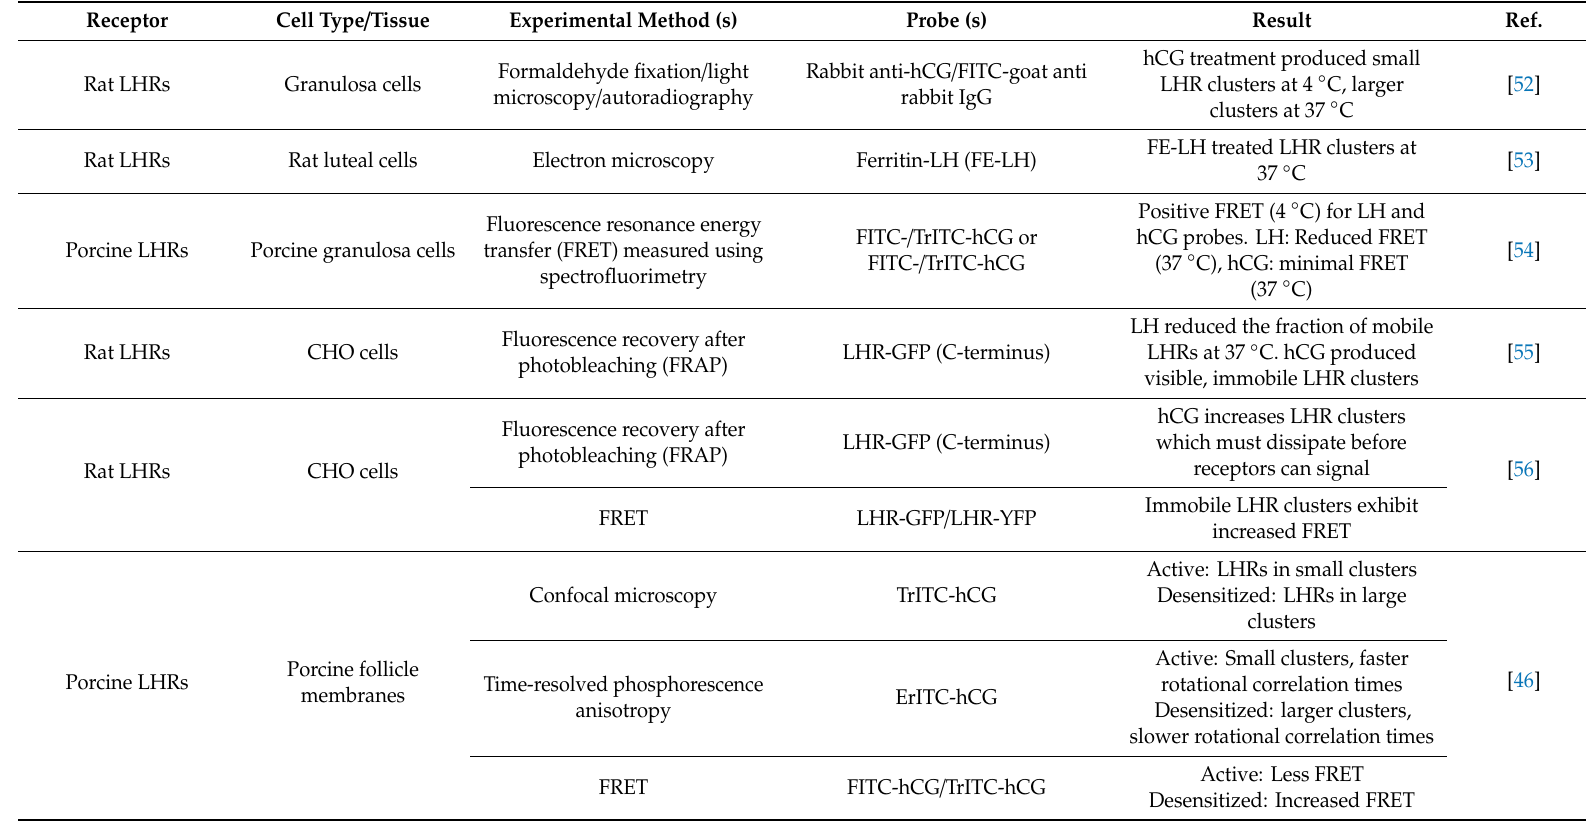
Table 1. Survey of various experimental methods used to evaluate luteinizing hormone receptor (LHR) and follicle-stimulating hormone receptor (FSHR)